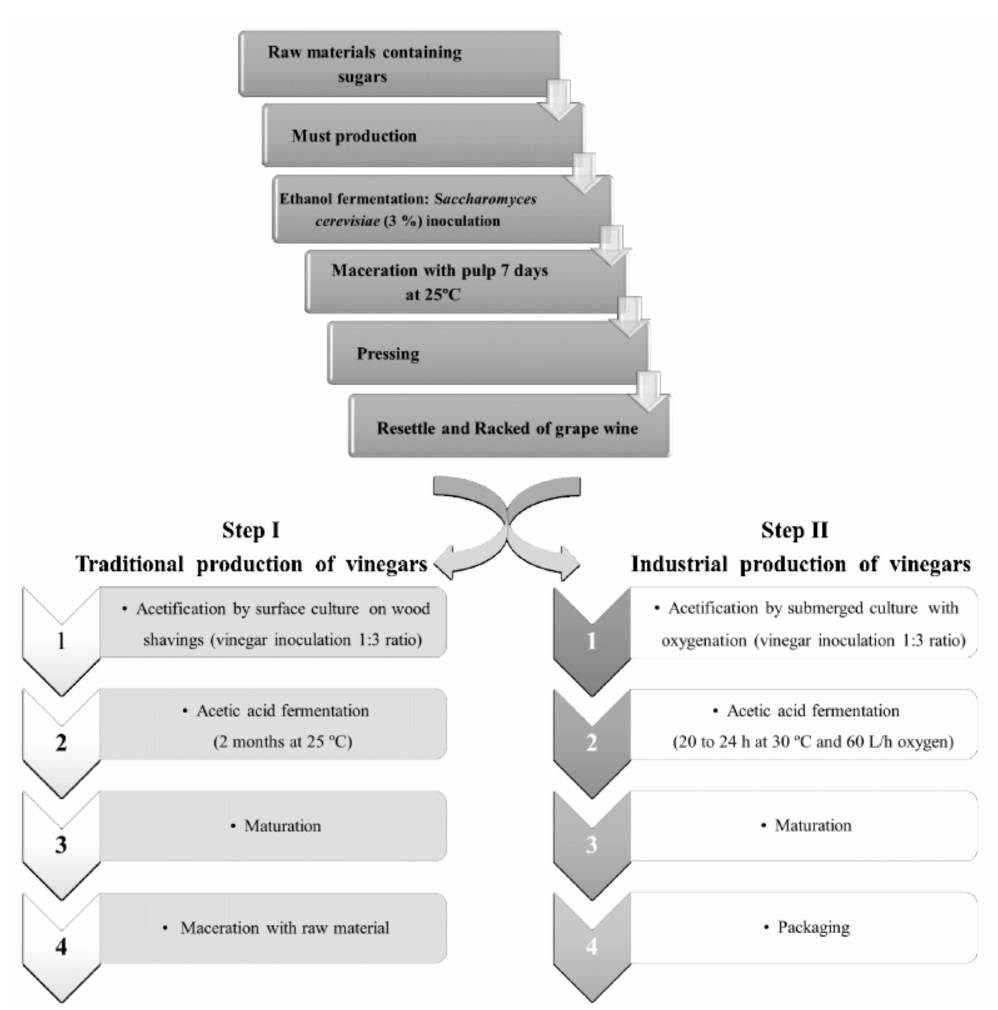
Figure 1. Flowchart showing the general production methods for vinegar